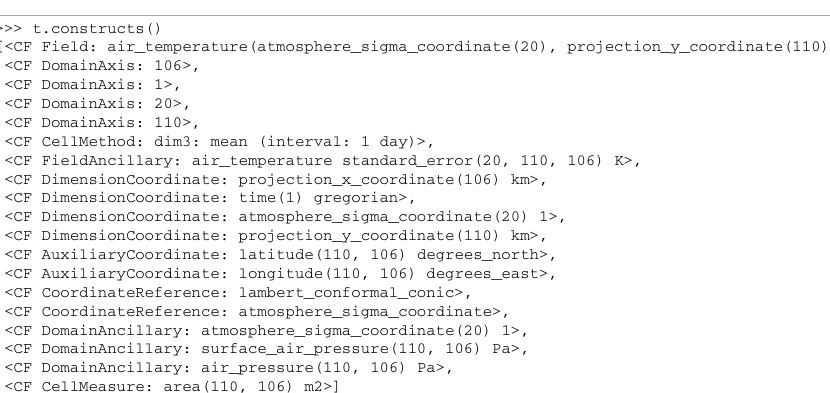
Figure 18. The cf-python class instances which correspond to CF data model constructs.